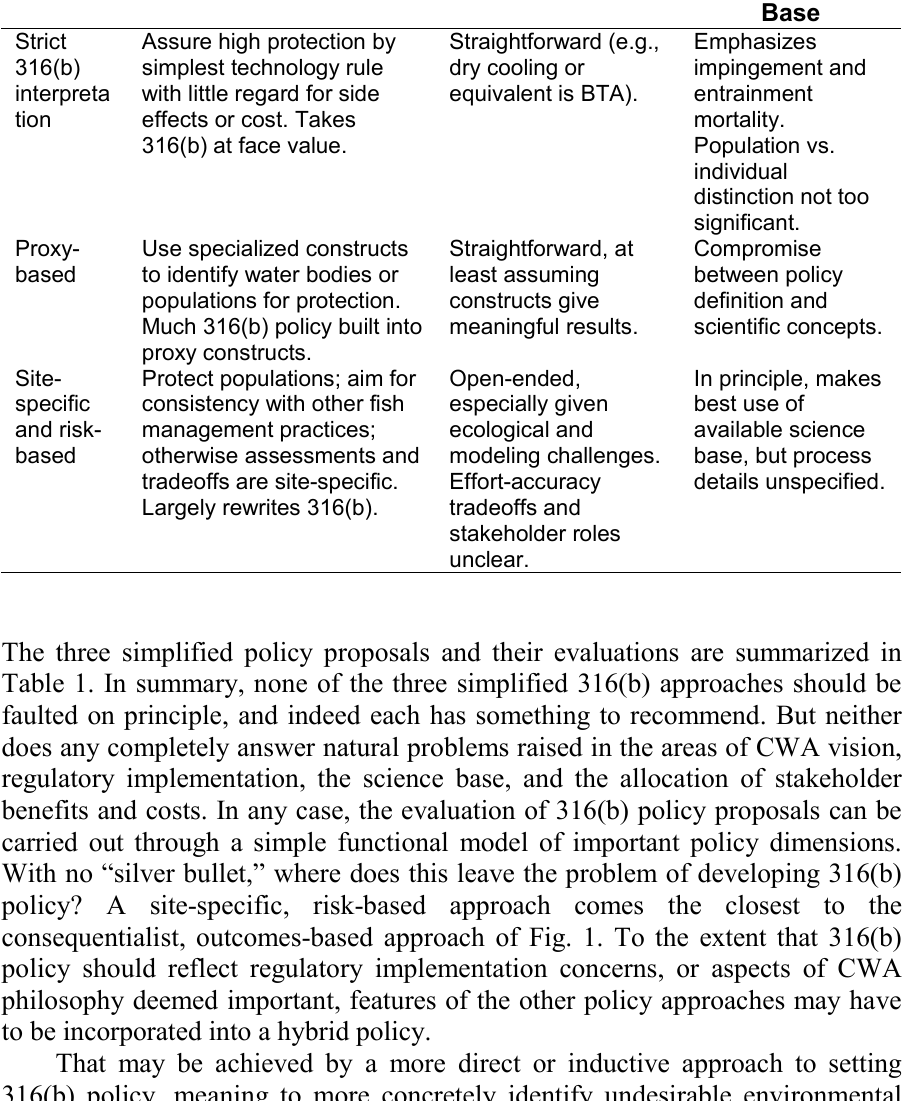
Coarse Evaluation of Simplified 316(b) Policy Approaches CWA Policy Vision Implementation